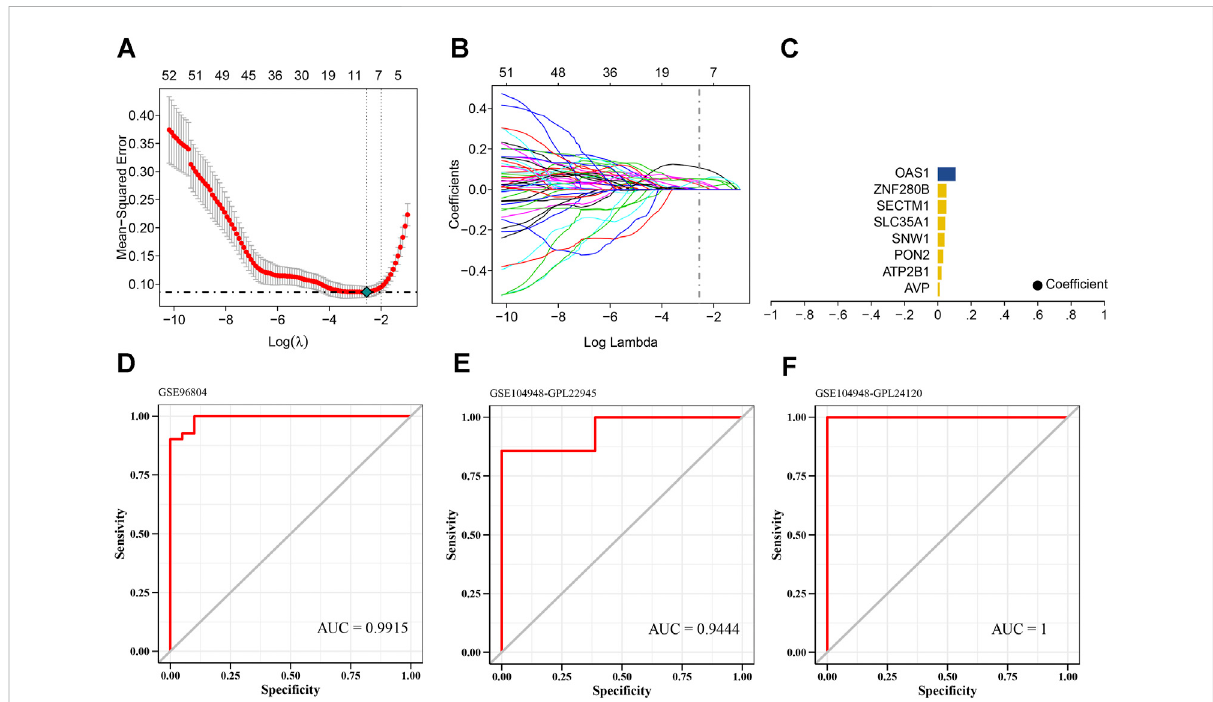
FIGURE 5 ScreeningofcoregenesinDKD. (A)